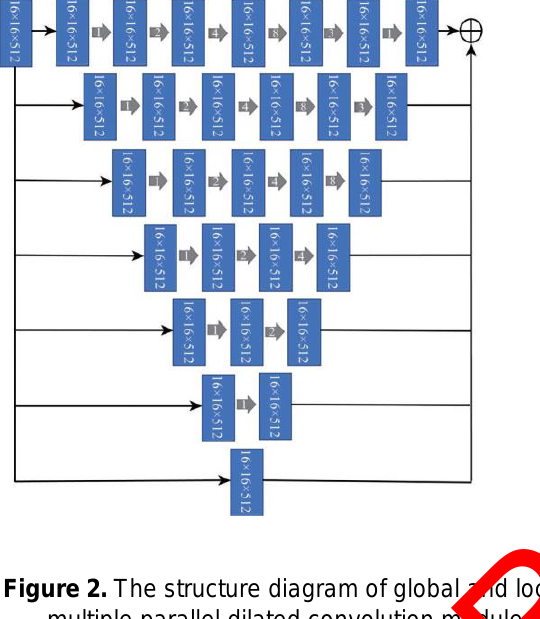
Figure 2. The structure diagram of global and local multiple parallel dilated convolution module